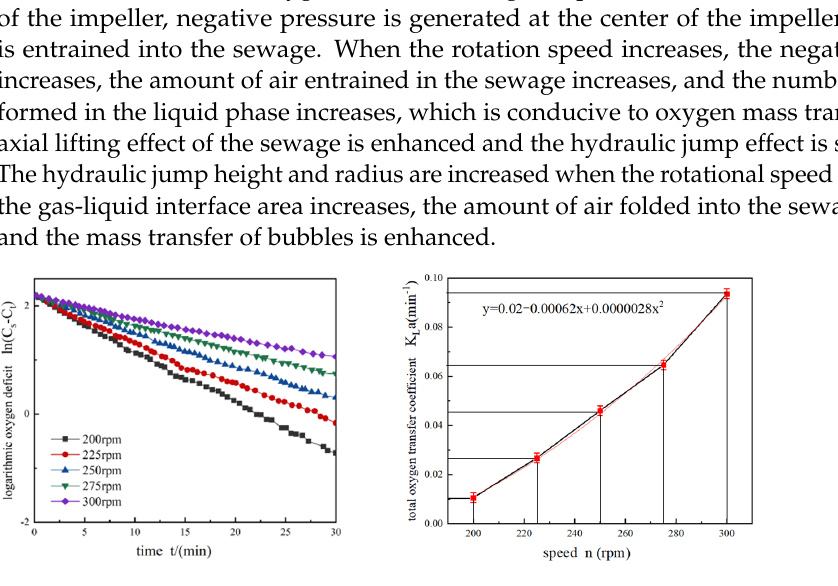
( b ) Figure 10. The logarithmic oxygen deficit and total oxygen transfer coefficient at different speeds: ( a ) logarithmic oxygen deficit; ( b ) total oxygen transfer coefficient. As shown in Figure 11, the total oxygen transfer coefficient first increases and then decreases. The dissolved oxygen transfer rate first increases and then decreases with the increase in immersion depth. The dissolved oxygen rate reaches the maximum at an immersion depth of − 20 mm. When the immersion depth is higher than 0 mm, the impeller’s effect of sewage lifting is weakened, and the hydraulic jump effect is notably weakened. When the impeller is at the same level as the liquid level or is slightly lower,